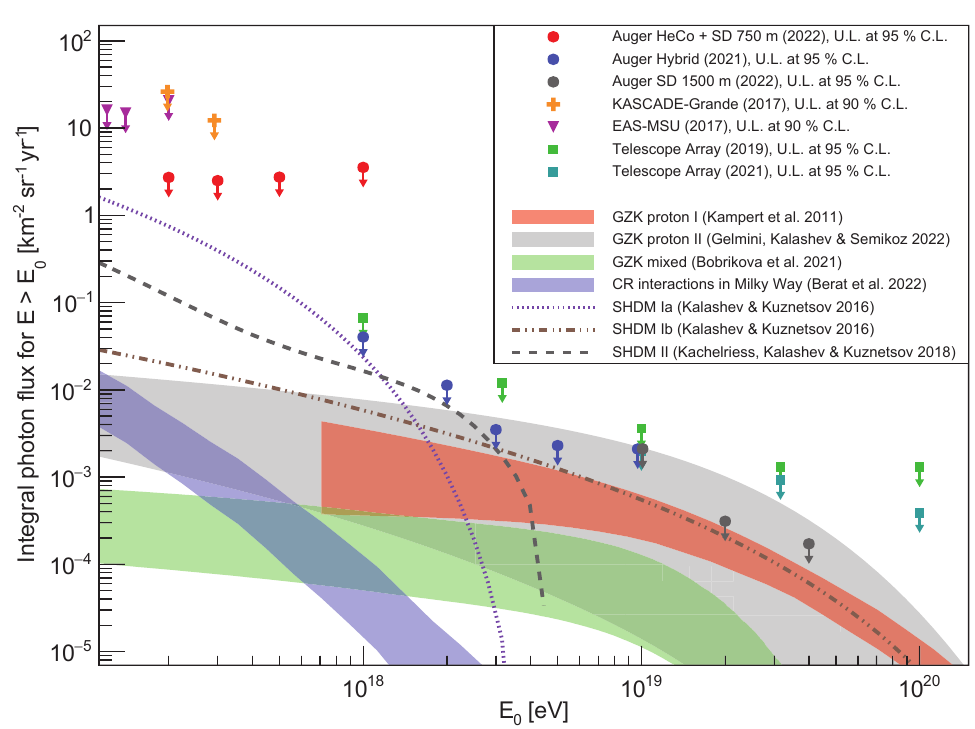
Figure 2. Current upper limits on the integral photon flux determined from data collected by the Pierre Auger Observatory (red, blue and gray circles); shown are also upper limits published by other experiments as well as the expected photon fluxes under di ff erent theoretical assumptions and scenarios; for a full list of references, see